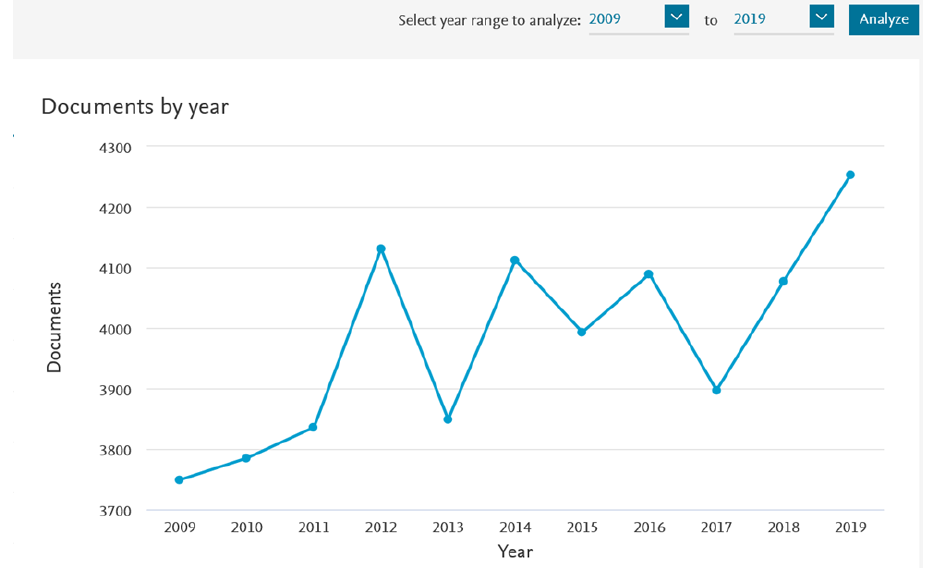
Figure 2. Results analysis for Scopus query “chiral” in titles, keywords, or abstract sections of articles between 2009 and 2019 (Limited to Chemistry).